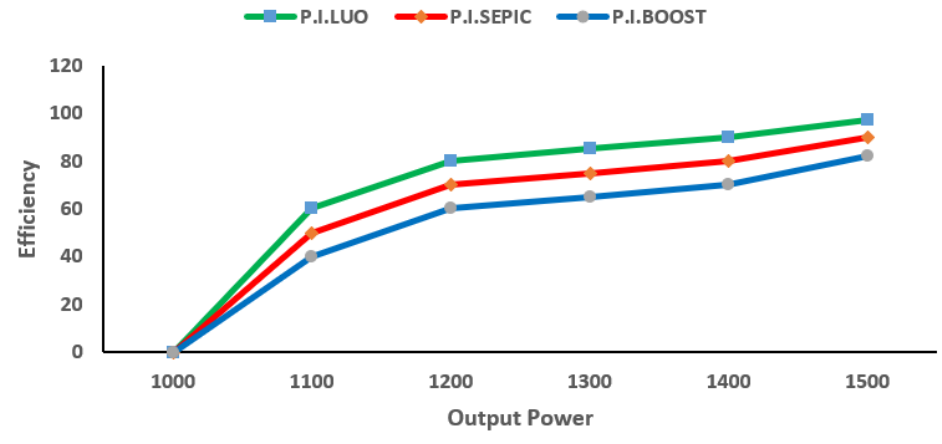
Figure A2. Efficiency comparison of different converters with the optimized controller. Figure A2. E ffi ciency comparison of di ff erent converters with the optimized controller.